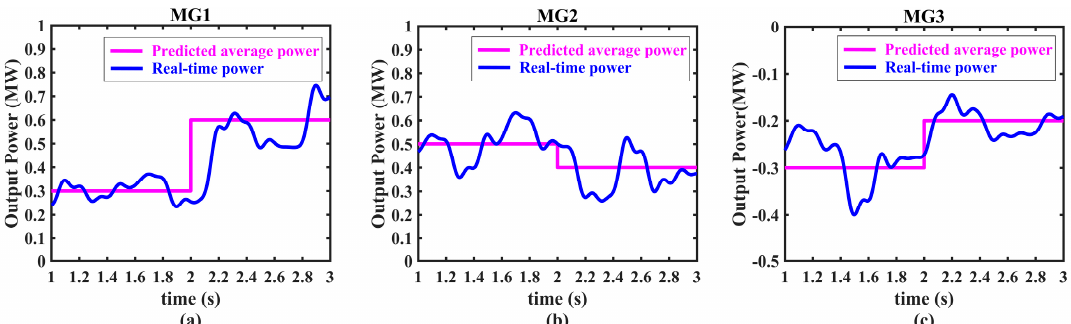
Figure 6. Predicted average output power and real-time output power of sub-microgrids. ( a ) MG1 output power; ( b ) MG2 output power; ( c ) MG3 output power. Table 3. Main parameters of the simulation